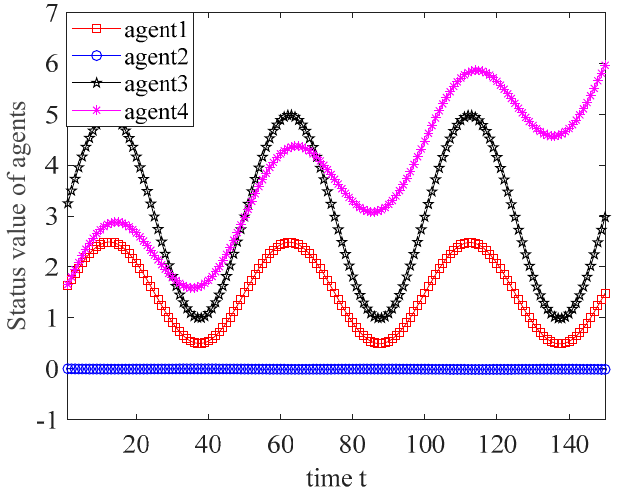
Figure 8. Convergence of system errors for multi-agent system with different packet loss rates with compensation: ( a ) k = 1, 2, …, 500; ( b ) k = 100, 101, …, 150.